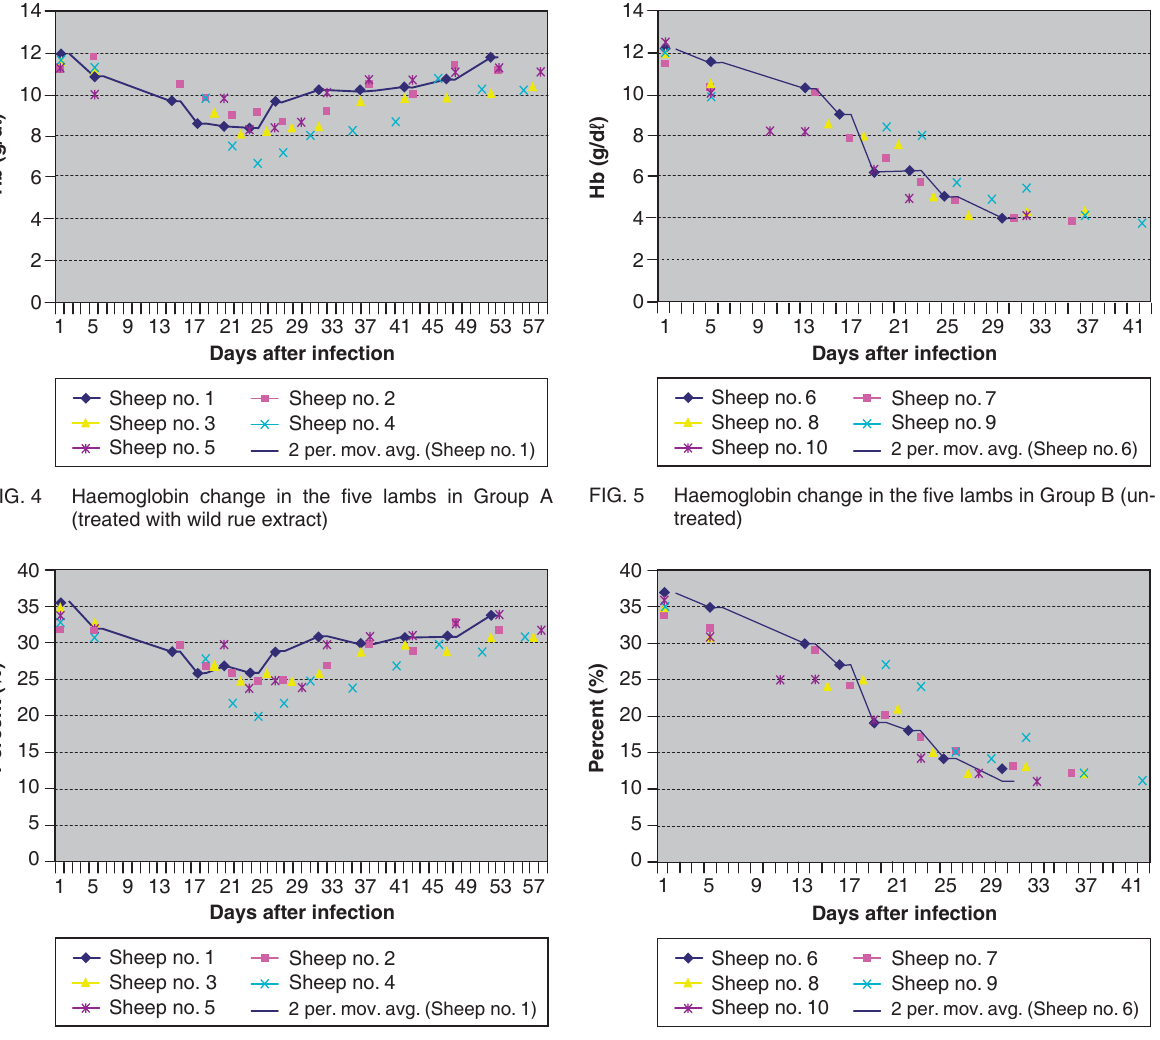
FIG. 6 Packed cell volume change in the five lambs in Group A (treated with wild rue extract)